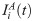
(A) Two ensembles of spike patterns are generated by distinct, N-dimensional inputs IA and IB repeatedly presented to the network on multiple trials, where initial states are chosen at random. This results in two network-wide response ensembles ΘIA and ΘIB containing spike patterns across neurons, time and trials. (B) Illustration of the two procedures used to control input similarity. Left: ρsame controls the number of neurons Nsame = ρsame
N that receive identical inputs Ii(t) under both stimuli IA(t) and IB(t). Right: correlation coefficient
ρcorr controls the correlation of all pairs of neural inputs IiA(t) and IiB(t) (note that Ii(t) and Ij(t) remain uncorrelated if i ≠ j).